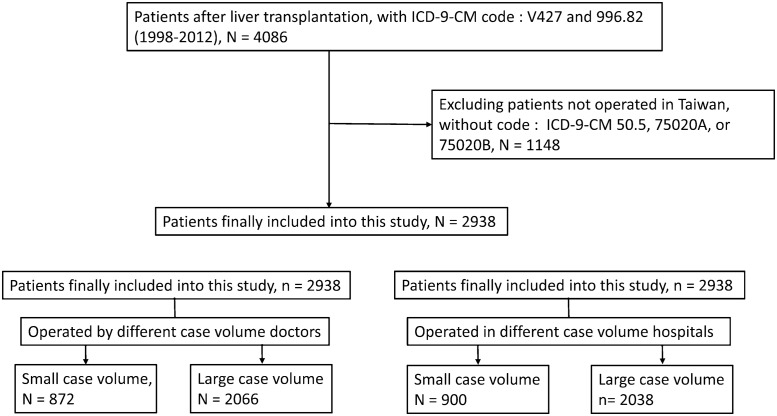
Flowchart of patient selection.